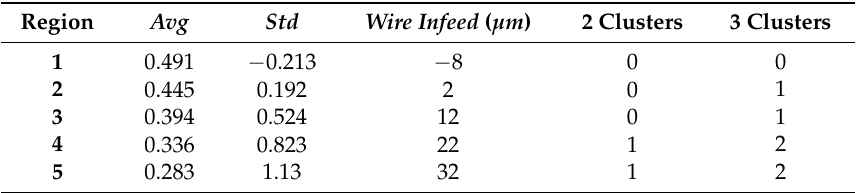
Table 5. Results obtained from K-means assuming 2 clusters and 3 clusters.